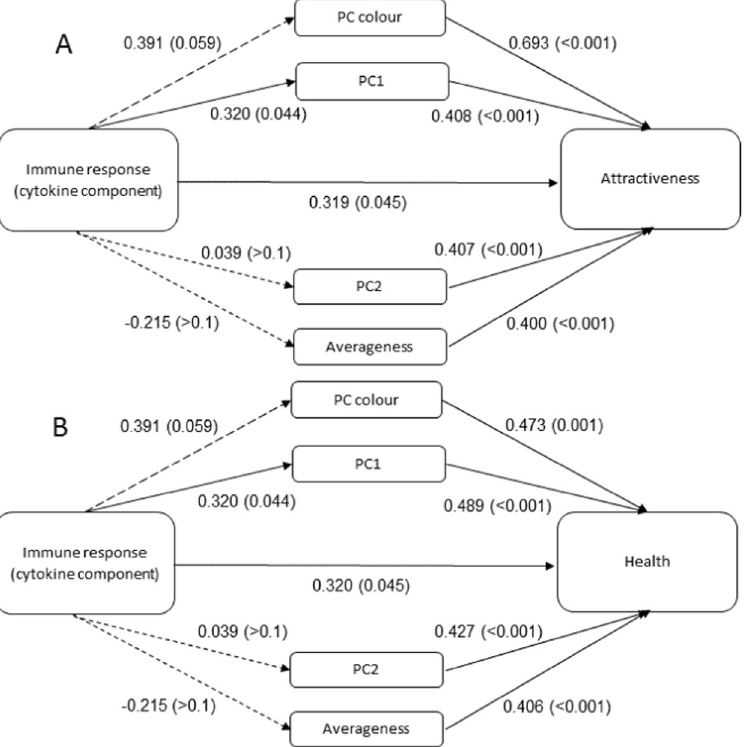
Figure 2. Pearson’s Correlation coefficients for ( A ) log facial attractiveness and ( B ) perceived health. Values indicate Pearson’s correlation coefficients (r) with associated p-values in brackets. Short dashed lines indicate non-significant coefficients (p > 0.05), long dashed lines marginal associations (p < 0.1) and solid lines significant associations (p < 0.05). PC1 = masculinity, adiposity component; PC2 = symmetry, adiposity